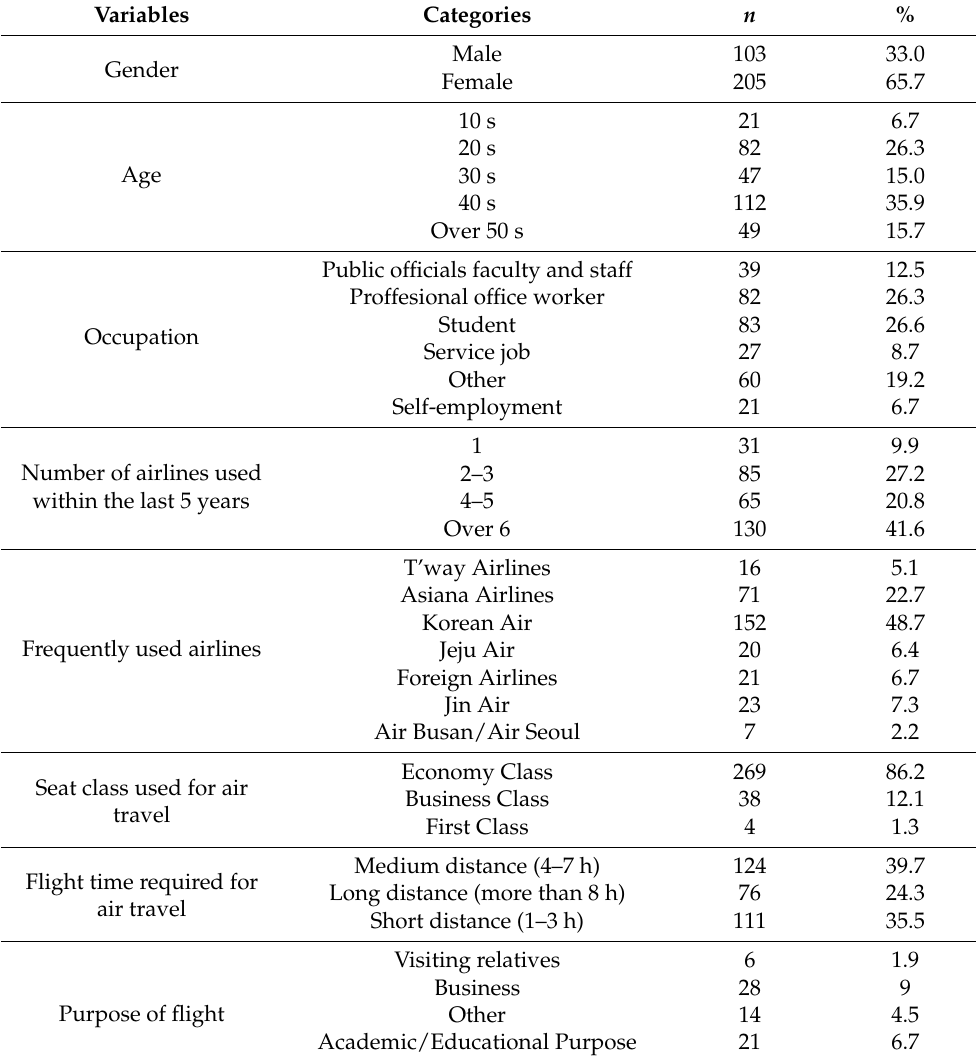
Table 1. Summary of responders’